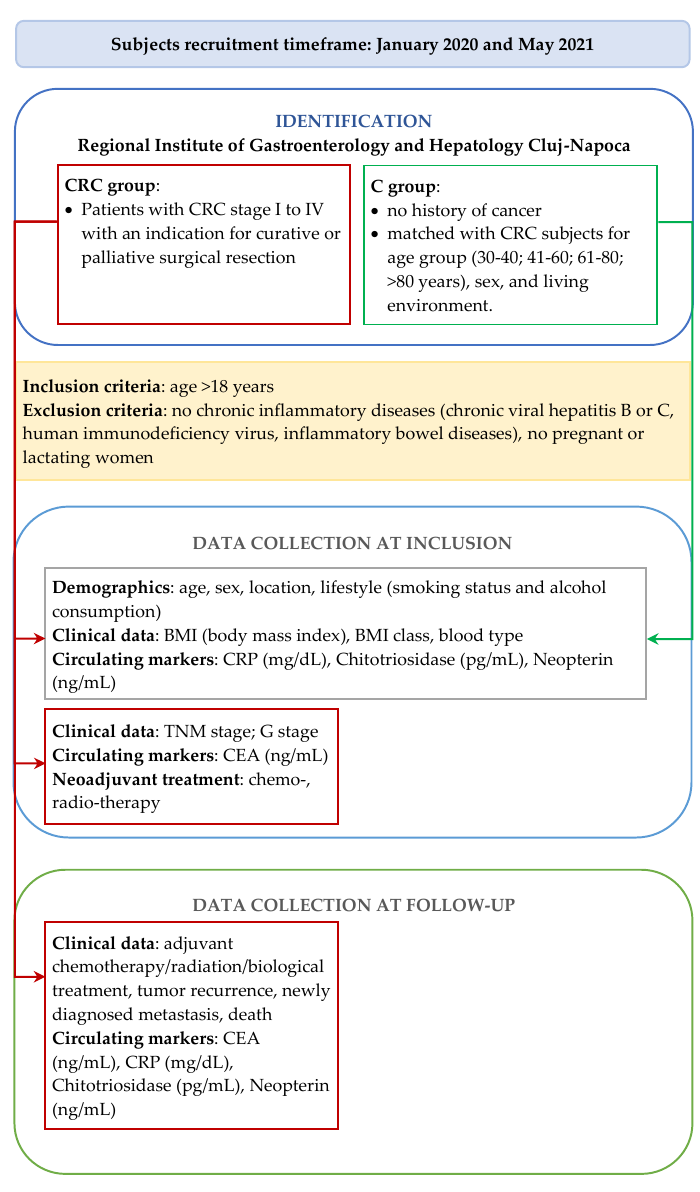
PRISMA 2020 flow diagram for new systematic reviews which included searches of databases, registers and other sources